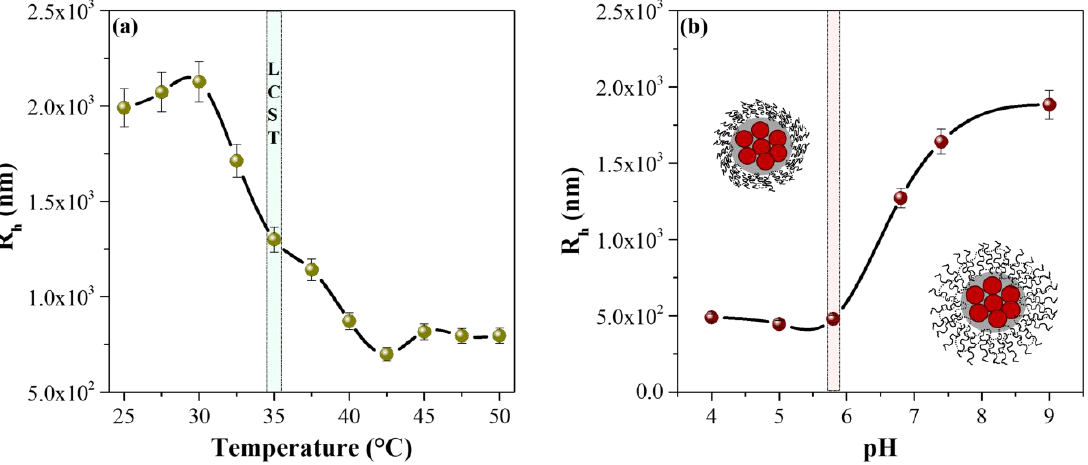
Figure 8. LCST ( a ) and pH response ( b ) of MPNsFe 3 O 4 -SiO 2 -poly(NVCL-co-MAA) 33% nanocompo- site.